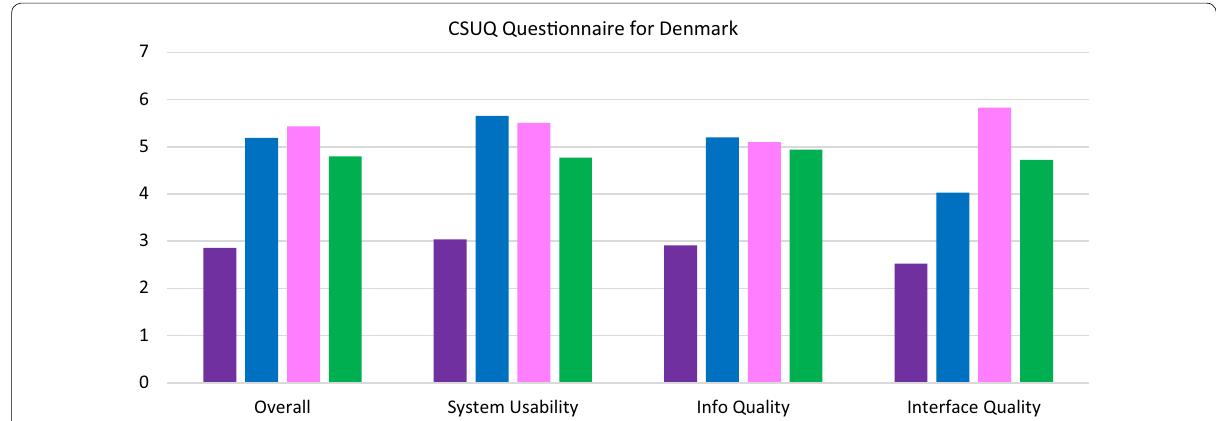
Fig. 5 Pulso system and wristband system. Trilogis‑Monsenso system and wristband system. Patient‑based evaluation of the Trilogis‑Monsenso and the PULSO system measured using the CSUQ